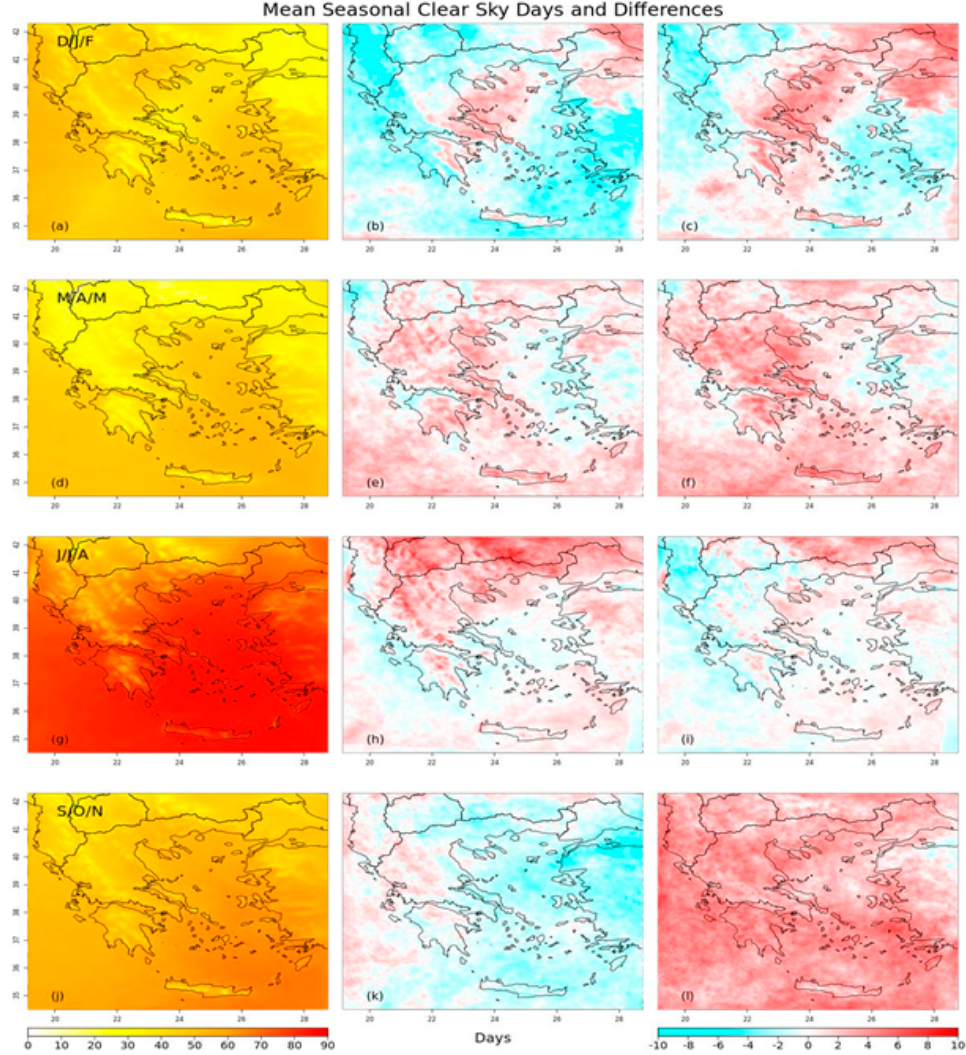
Figure 9. Mean seasonal clear-sky days of ( a , d , g , f ) historical period and numerical change to ( b , e , h , k ) RCP 4.5 and ( c , f , i , l ) RCP 8.5